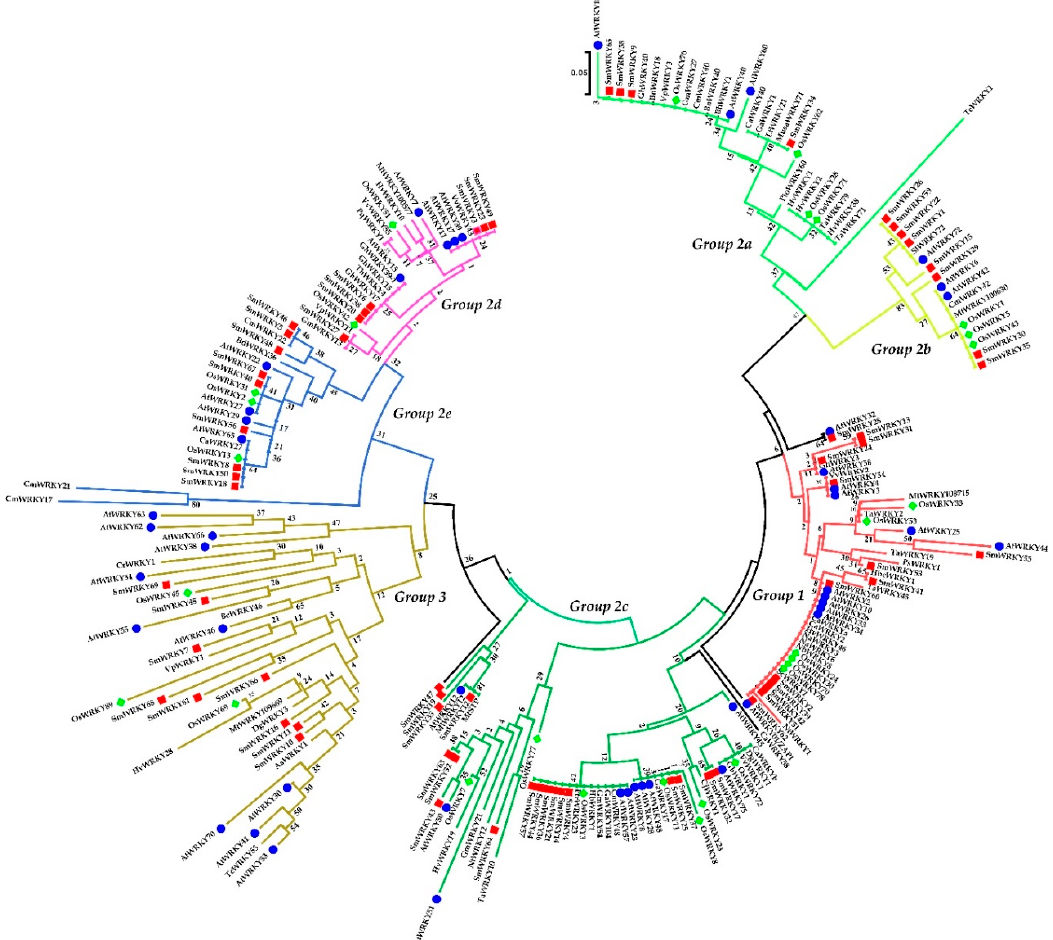
Figure 1. Phylogenetic tree of the WRKY from S. miltiorrhiza and other plants. The tree was constructed from amino sequences using MEGA 6.0 by the neighbor-joining (NJ) program with 1000 bootstrap replicates. Clades with different colors represent diverse group/subgroup.